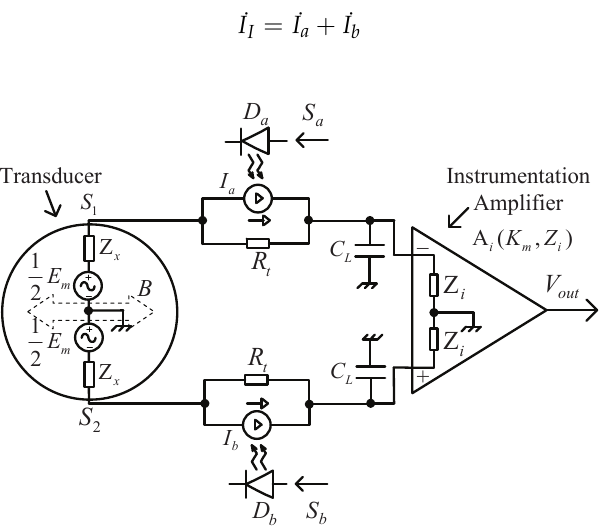
Figure 4. Schematic diagram of the dual-excitation EMFM based on a PV